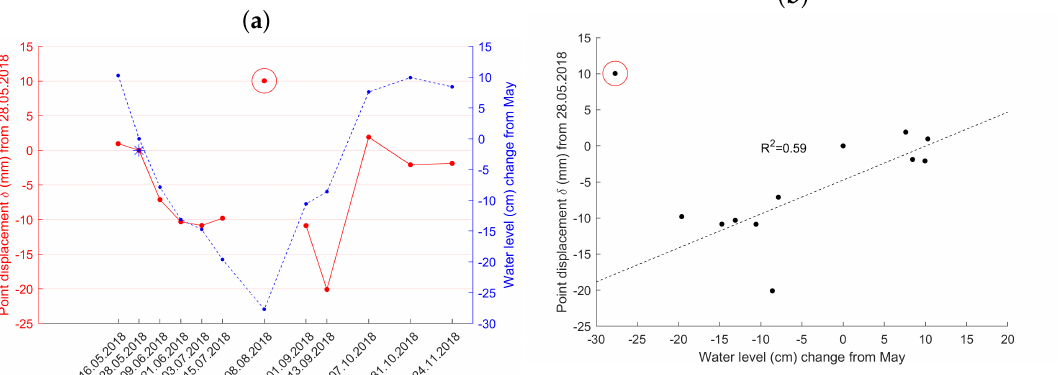
Figure 10. ( a ) Elevation changes (mm) of a chosen control point during the growing season in Kanamatsi bog (location of the point is shown in Figure 9a by a black circle and a red dotted line in Figure 9b) from 16 May to 24 November 2018 related to a single master image (28 May 2018) along with the mean water table change in the sampling wells (blue dotted line). The image pair 28 May–8 August, is marked as an outlier due to very low coherence. ( b ) The linear regression between the same elevation changes (mm) and water level measurements (cm). The outlier is not included in the